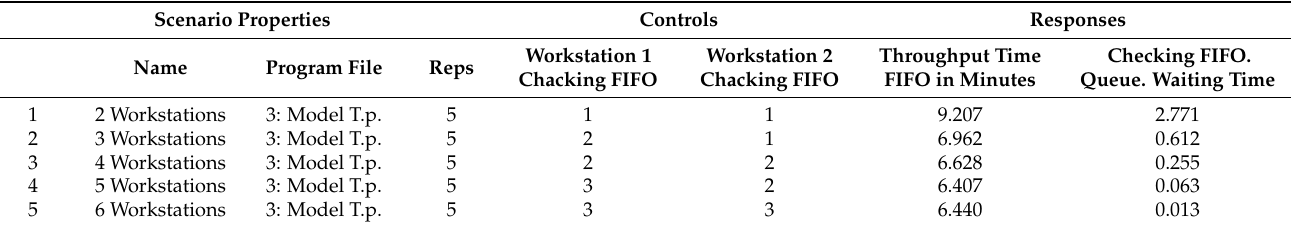
Table 9. Process Analyzer